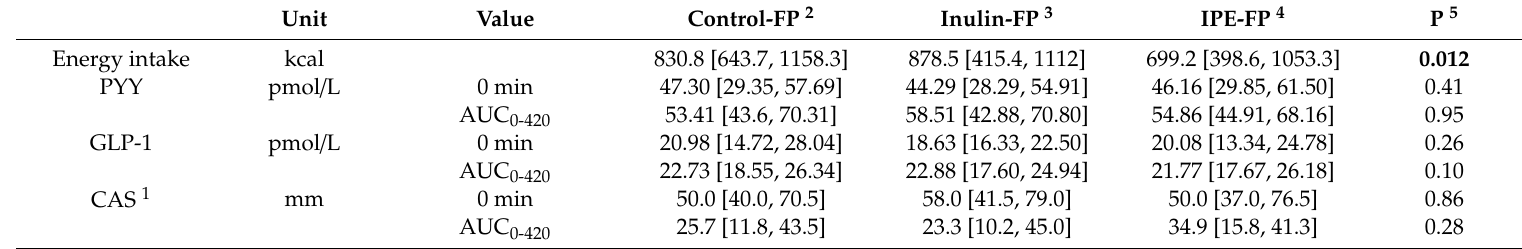
Table 2. Ad libitum energy intake, gut hormone and composite appetite score measures following a seven-day supplementation with inulin-FP or IPE-FP compared to